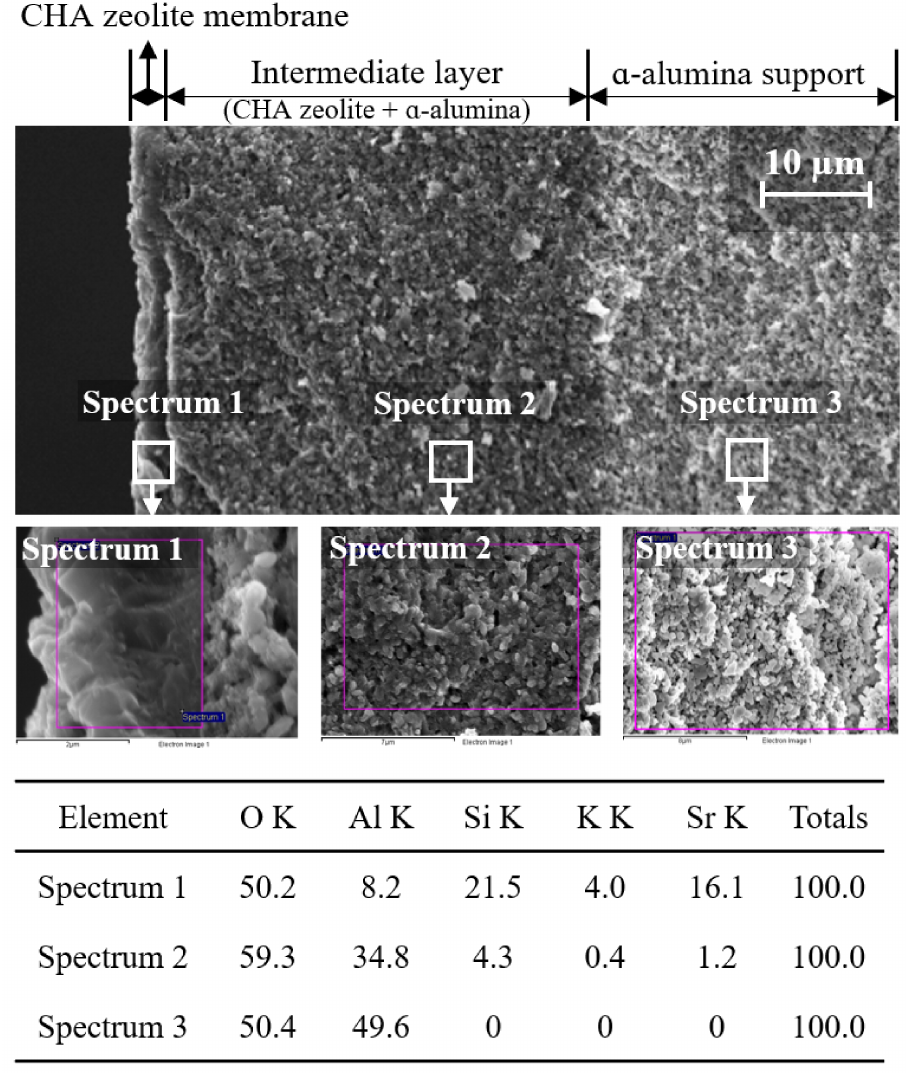
Figure 8. EDS results for three parts of M5 CHA zeolite membrane: (spectrum 1) zeolite separation layer, (spectrum 2) intermediate layer, and (spectrum 3)